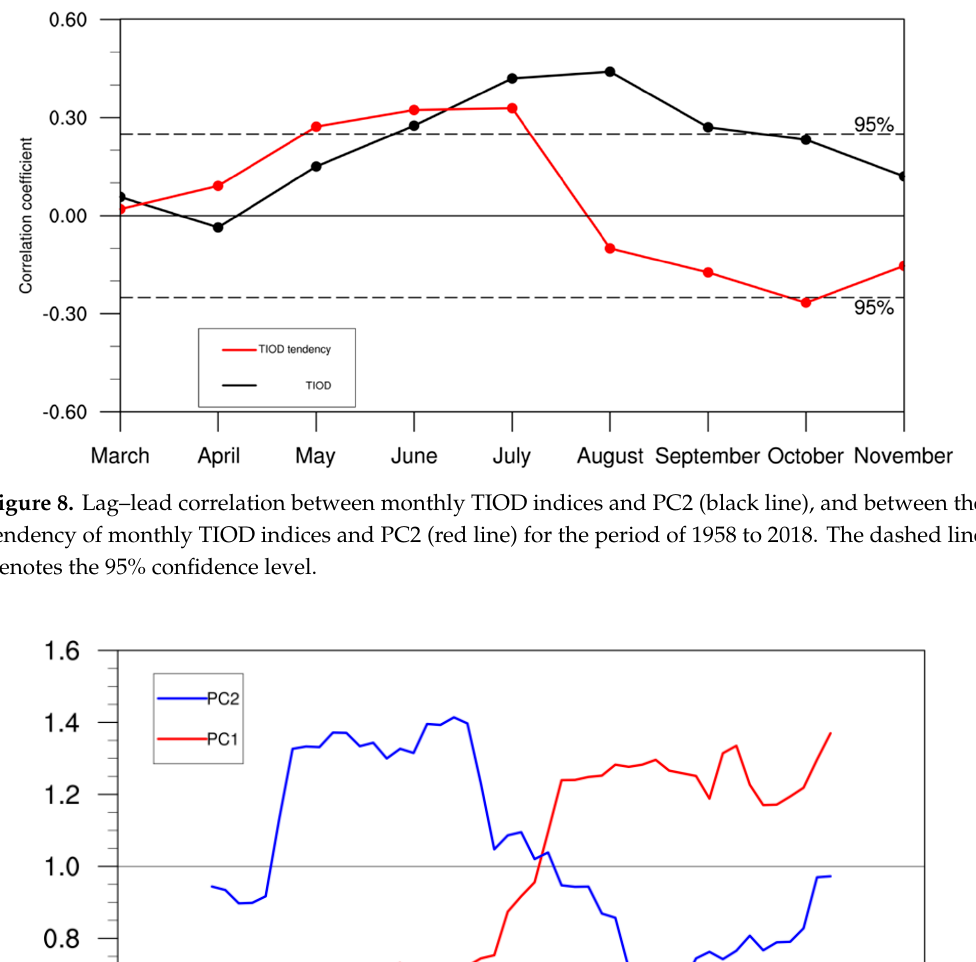
Figure 8. Lag–lead correlation between monthly TIOD indices and PC2 (black line), and between the tendency of monthly TIOD indices and PC2 (red line) for the period of 1958 to 2018. The dashed line denotes the 95% confidence level.